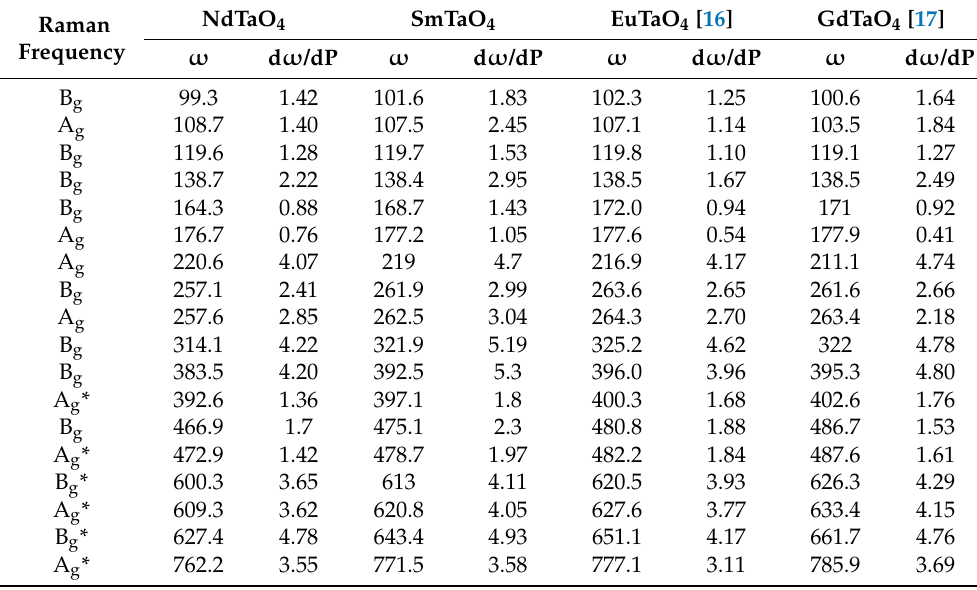
Table 3. Calculated Raman modes for NdTaO 4 and SmTaO 4 at ambient pressure along with their pressure coefficients (present work). Reported data of earlier studies on EuTaO 4 and GdTaO 4 have been included for comparison. Frequencies marked with an asterisk (*) correspond to internal modes of TaO 6 octahedra.